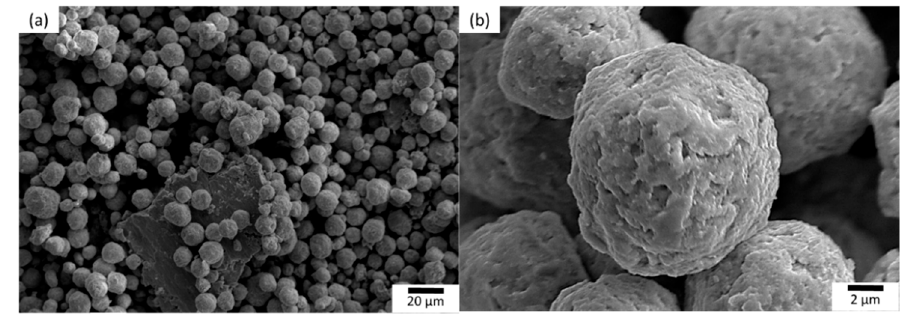
Figure 3. SEM images of mechanically alloyed powder at; ( a ) low, and ( b ) high magnifications.